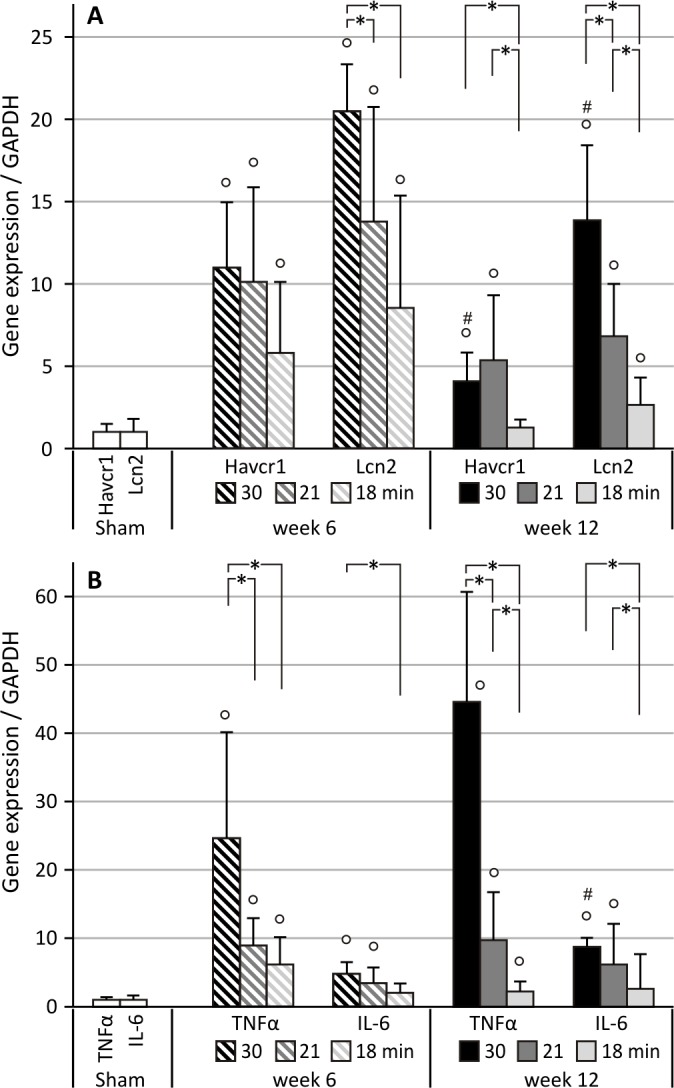
Relative quantification of long-term IRI-induced expression of tubular injury and inflammatory markers.*: p<0.05, °: p<0.05 vs. Sham, #: p<0.05 vs. week 6. UIRI was performed for 30, 21 or 18 minutes at 36°C and animals were euthanized 6 weeks (resp. n = 5, n = 12, n = 6) and 12 weeks (resp. n = 4, n = 5, n = 10) after UIRI. A: Six weeks after 30, 21 and 18 minutes of UIRI, a significant increase in gene expression of tubular injury markers Havcr1 (KIM-1) and Lcn2 (NGAL) was observed. At 12 weeks after UIRI, upregulation of these markers is ischemia-time dependent, with higher upregulation with longer ischemia times. B: Six weeks after 30, 21 and 18 minutes of UIRI, a significant increase in gene expression of inflammatory cytokines TNFα and IL-6 was observed. In addition, short ischemia times, i.e. 18 minutes of UIRI, induced significantly lower gene expression of these markers. At 12 weeks after UIRI, upregulation of these inflammatory cytokines shows an ischemia-time dependent effect, with shorter ischemia times inducing less upregulation of gene expression of these inflammatory markers.